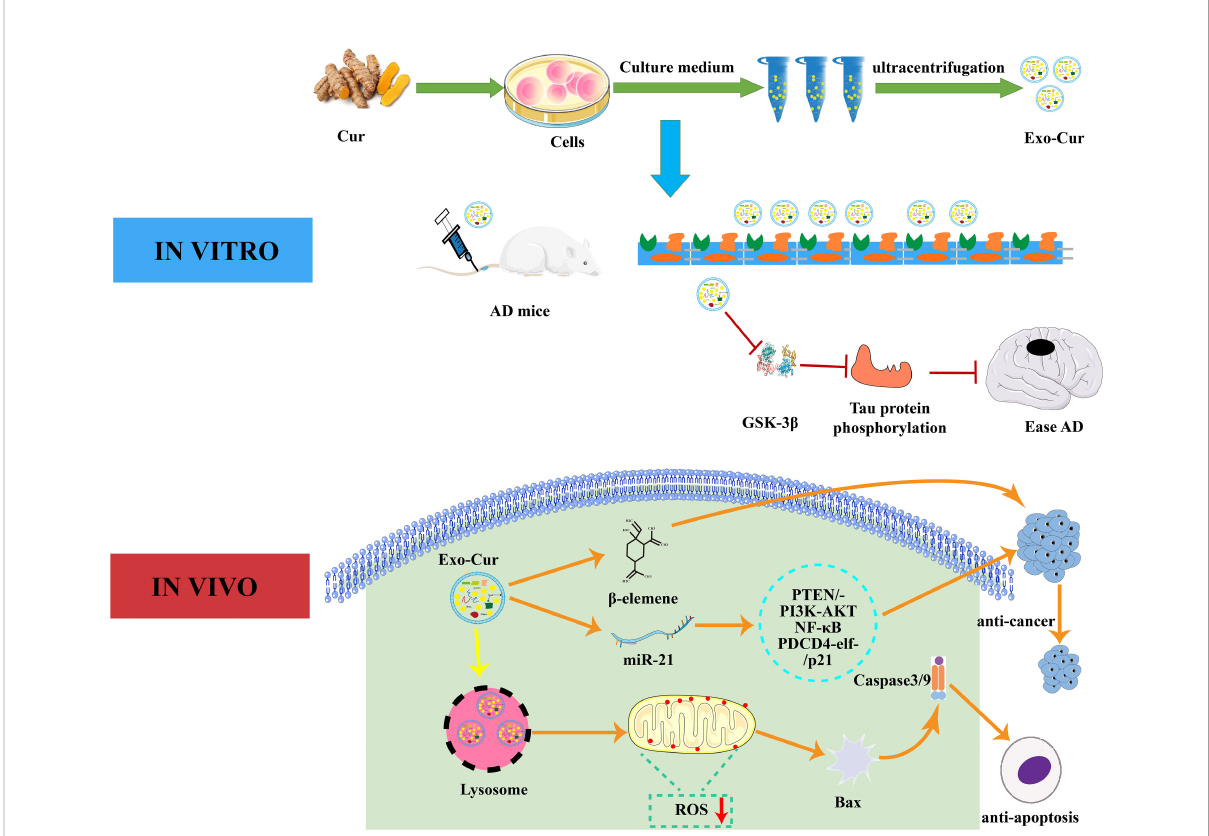
FIGURE 3 Interaction mechanism between EVs and curcumin. In vitro , curcumin-primed exosomes potently ameliorate cognitive function in AD model by inhibiting hyperphosphorylation of the Tau protein through the AKT/GSK-3 b pathway. In vivo , Exo-Cur mediates various effects on cancer cells including proliferation, apoptosis, metastasis and anti-cancer drug resistance. Cur, curcumin; Exo, Exosomes; AD, Alzheimer ’ s disease; PTEN/ PI3K/AKT, phosphatase and tensin homolog/phosphoinositide 3-kinase/protein kinase B; PDCD4, programmed cell death protein 4; GSK-3 b , glucogen synthase kinase-3 beta; BBB, blood brain